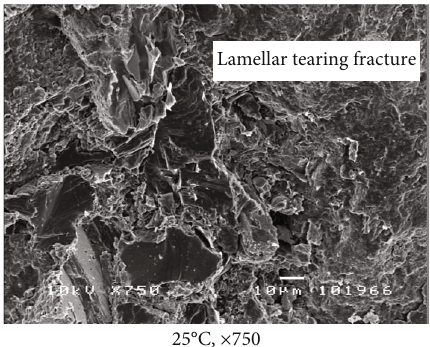
Parallel slip line pattern